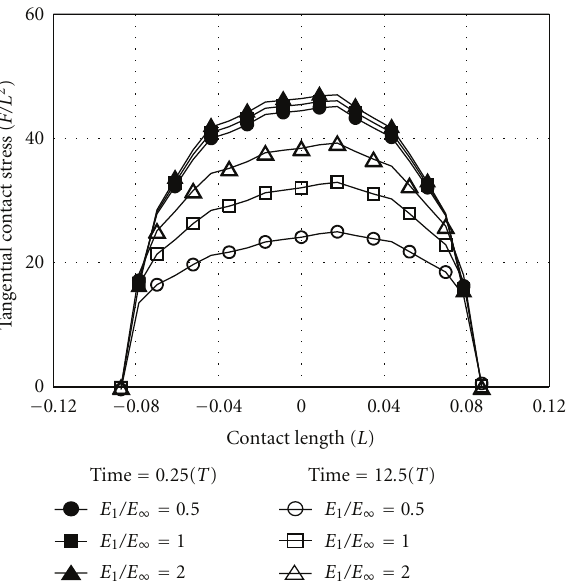
Figure 13: E ff ect of E 1 /E ∞ on relaxation of the central tangential contact